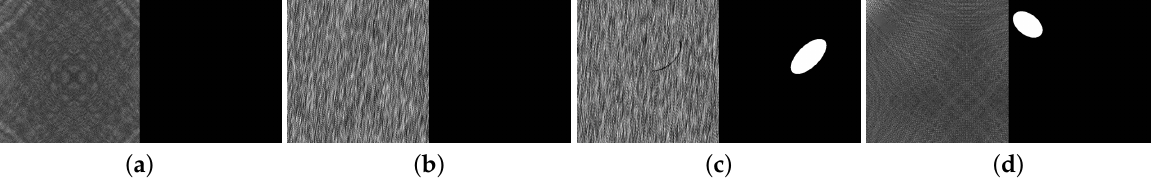
Figure 9. Example images of DAGM. ( a , b ) are the raw images without defects and its ground truth; ( c , d ) are the raw images with defects and their ground